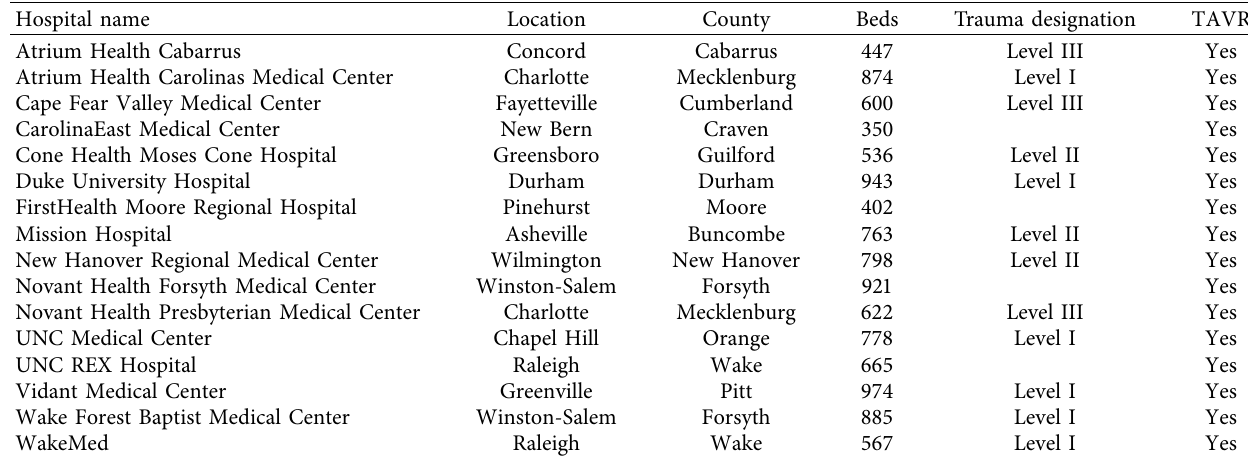
Table 5: List of TAVR centers in North Carolina.